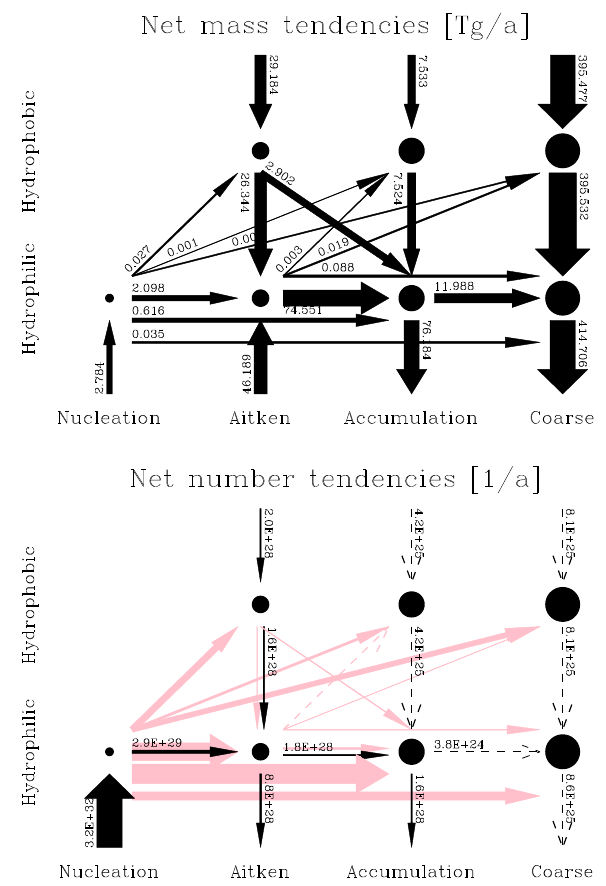
Figure 4. Globally and annually averaged net mass and number ten- Fig. 4. Globally and annually averaged net mass and number dencies (arrows) between the seven modes (dots) in ECHAM5.5- tendencies (arrows) between the 7 modes (dots) in ECHAM5.5- HAM2. The vertical arrows at the top and bottom of the figure rep- HAM2. The vertical arrows at the top and bottom of the figure rep- resent H 2 SO 4 nucleation, condensation and production, aerosol pri- mary emission and deposition processes. The arrows between the resent H 2 SO 4 nucleation, condensation & production, aerosol pri- modes represent coagulation, aging and redistribution processes. mary emission and deposition processes. The arrows between the Pink arrows are number loss tendencies for coagulation processes. modes represent coagulation, ageing and redistribution processes. The width of the arrow scales logarithmically with the magnitude Pink arrows are number loss tendencies for coagulation processes. of the net tendency. In addition, numerical values for the annual and The width of the arrow scales logarithmically with the magnitude global averages are of the net tendency. In addition, numerical values for the annual and global averages are given.